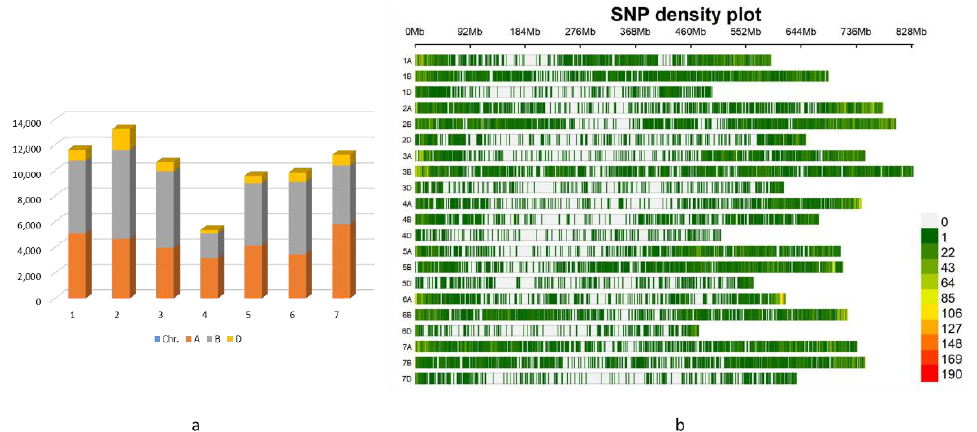
Figure 5. Distribution and density of SNPs mapped to the wheat genome: ( a ) Distribution of SNPs on 7 chromosomal groups, and the number of mapped SNPs on each wheat genome A, B, and D; ( b ) Density plot of SNPs mapped to the different wheat chromosomes.